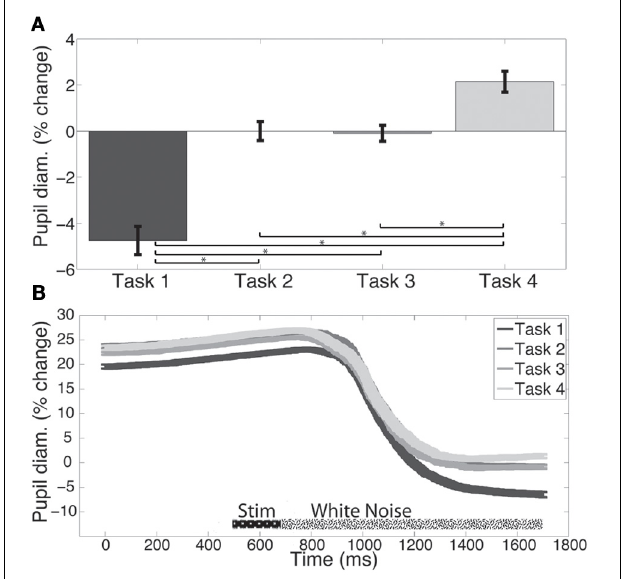
FIGURE 2 | (A) Pupil diameter is larger for more difficult tasks. Pupil diameter units are % change from the Task 2 condition. Within-subject error bars are shown. (B) Task-evoked pupillary response across time. Control and training groups’ baseline data representing the percent change of pupillary response over the different tasks. Values shown are percent change from the mean pupil diameter during the last 500ms of the white noise for Task 2. Within subject error bars are shown. Data from the last 500ms of the “White Noise” period correspond to the data in panel 2A . ∗ p < 0 . 05.